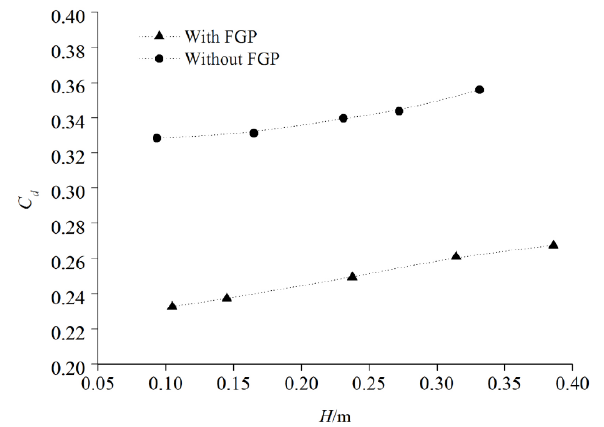
Figure 7. Relationship between the discharge coefficient ( C d ) and the weir head ( H ) for the cases with FGP ( β = 0.51, θ = 15°) and without FGP.